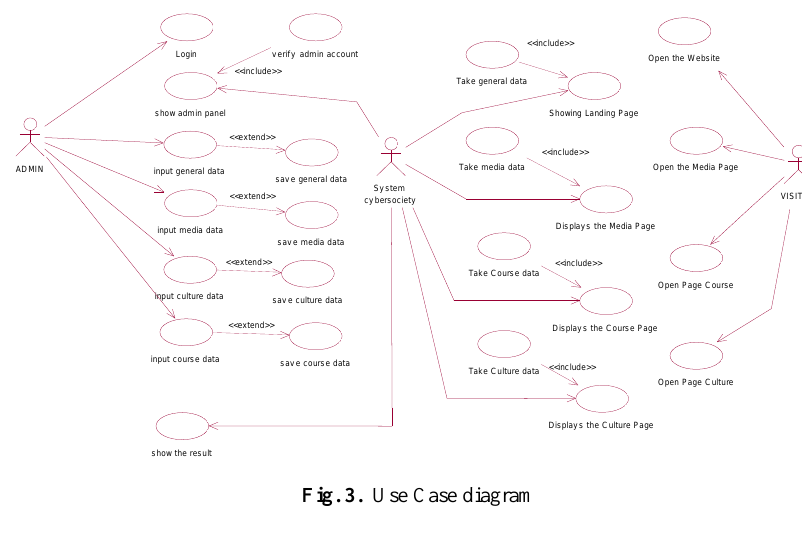
Fig. 3. Use Case diagram